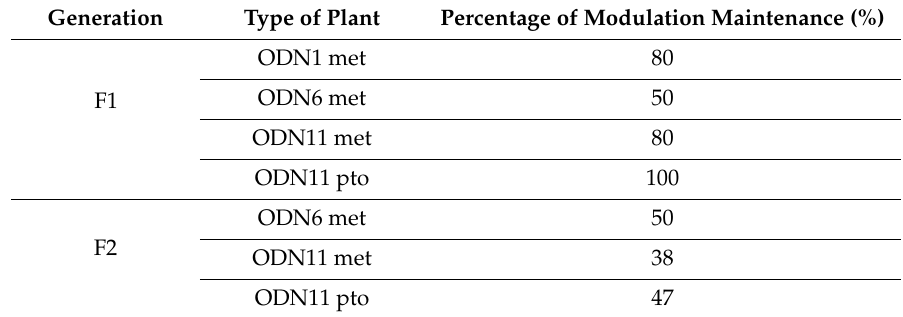
Table 3. Maintenance of gene expression modulation of CHS gene in F1 and F2 generations of plants treated with modified ODNs (met and